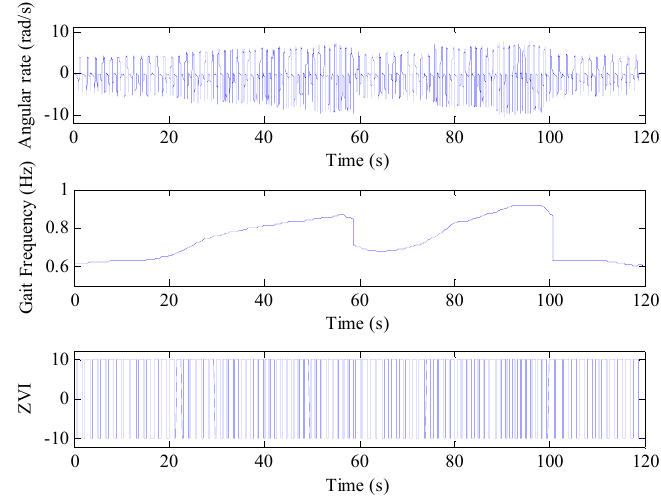
Figure 14. Gait frequency and ZVI detection results. In the bottom of the figure, − 10 represents ZVI and 10 indicates non-ZVI.